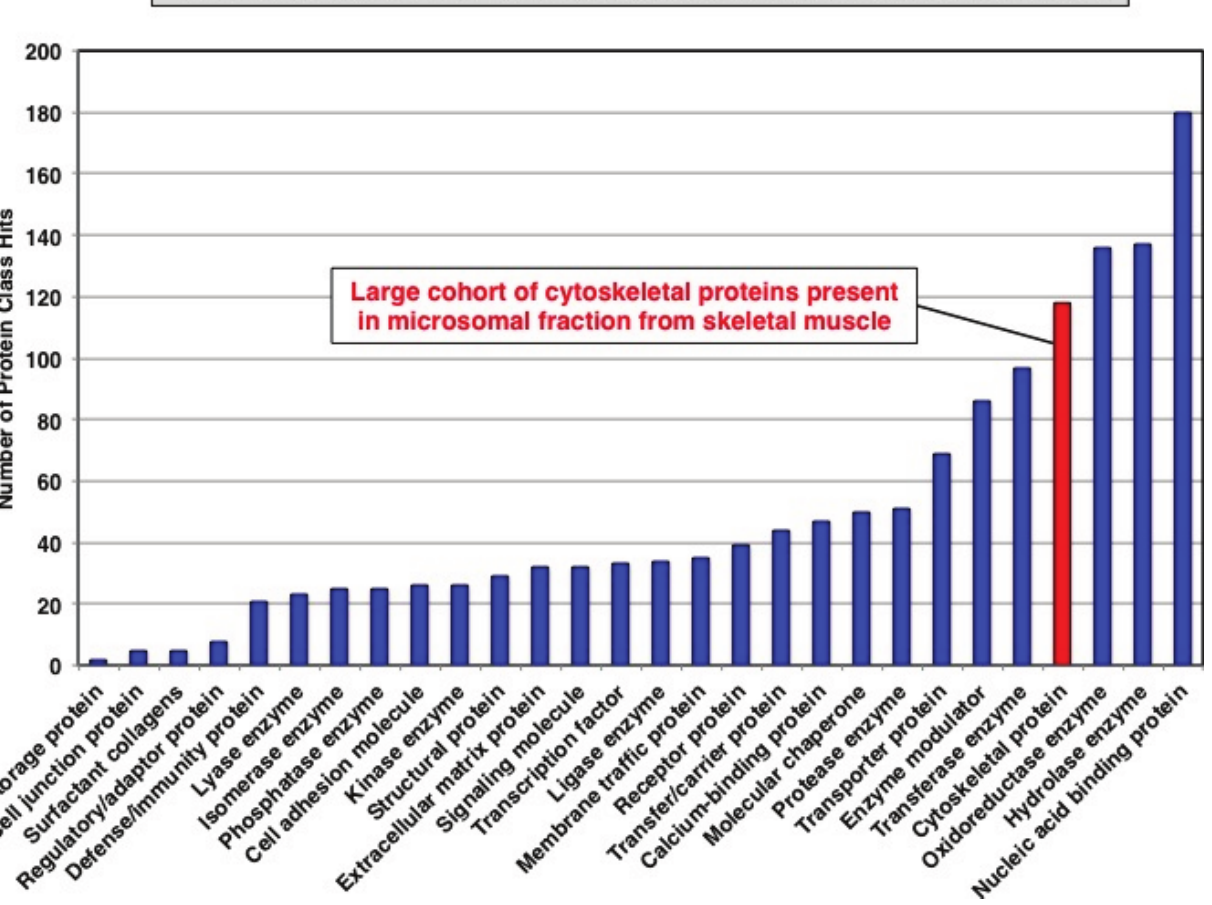
Figure 2. Overview of the distribution of protein classes present in the microsomal fraction from skeletal muscle as judged by label-free LC-MS/MS analysis and the bioinformatics listing according to the PANTHER database of protein families for the cataloguing of molecular functions